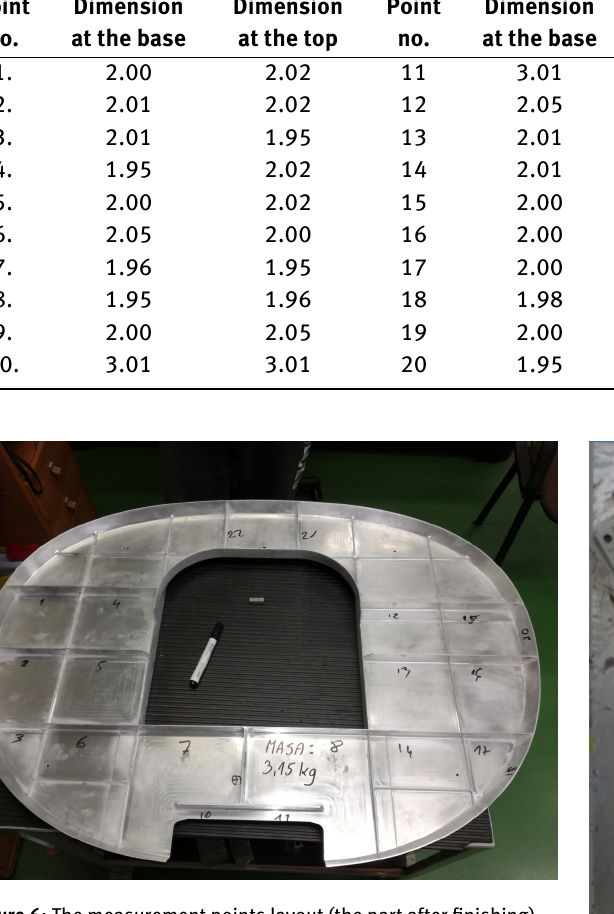
Table 3: Thickness dimensions of the particular frame walls Point